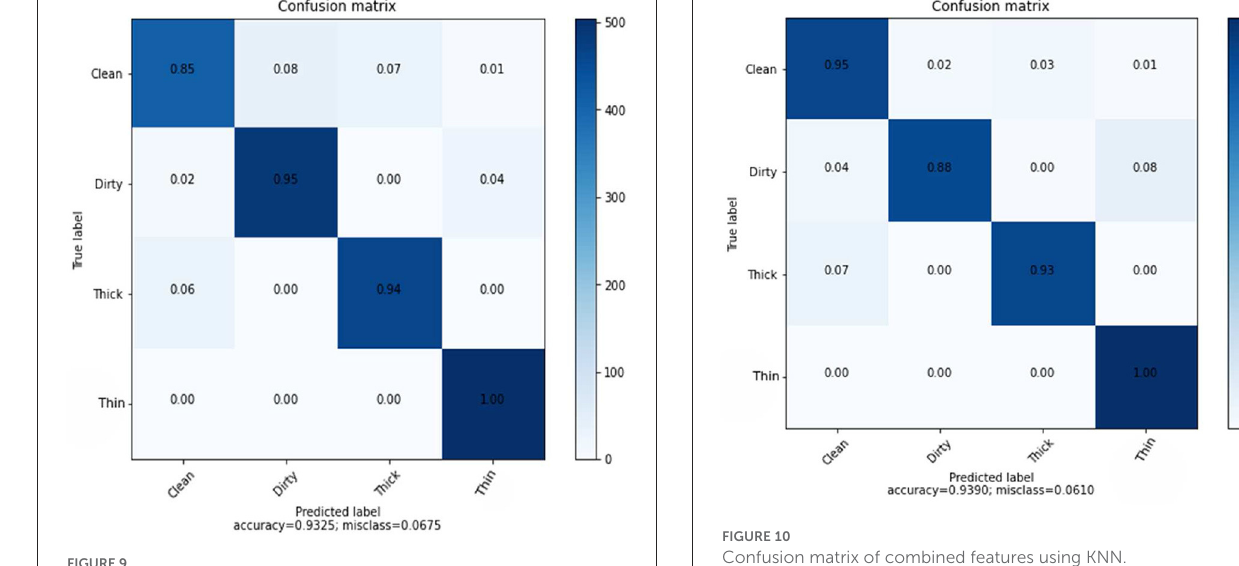
FIGURE9 Confusion matrix KNN using CNN feature.